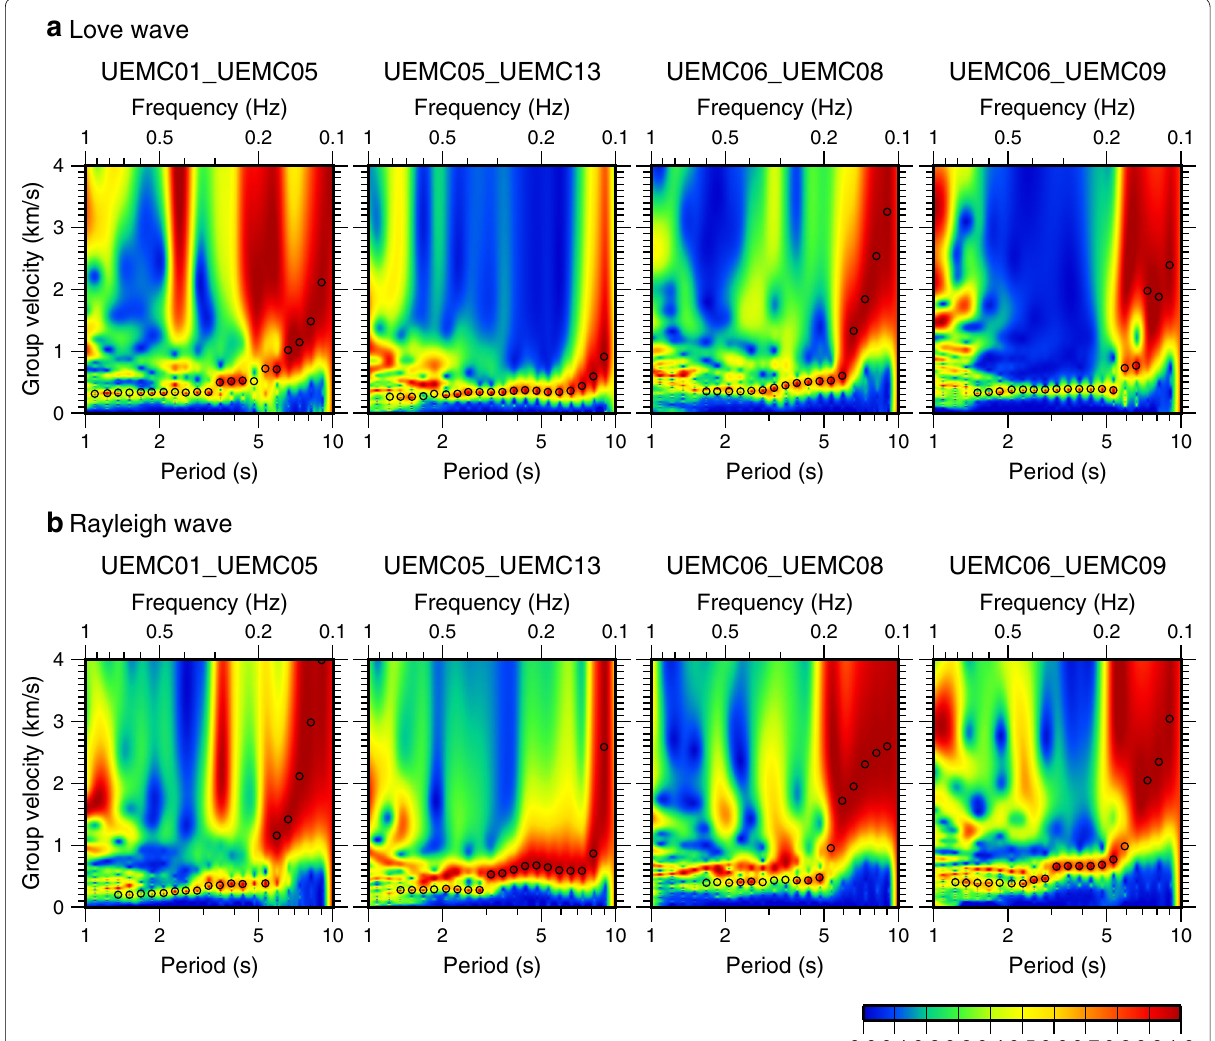
Fig. 8 Love and Rayleigh wave group velocities for four station pairs estimated by multiple filter analysis ( open circles ). The amplitudes of the cross- correlation functions normalized at each period are shown with the color